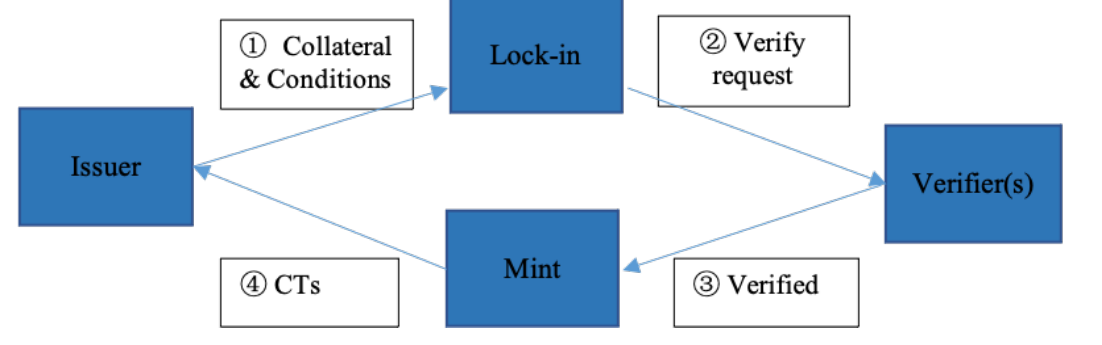
Figure 2. Obligatory-type CT.